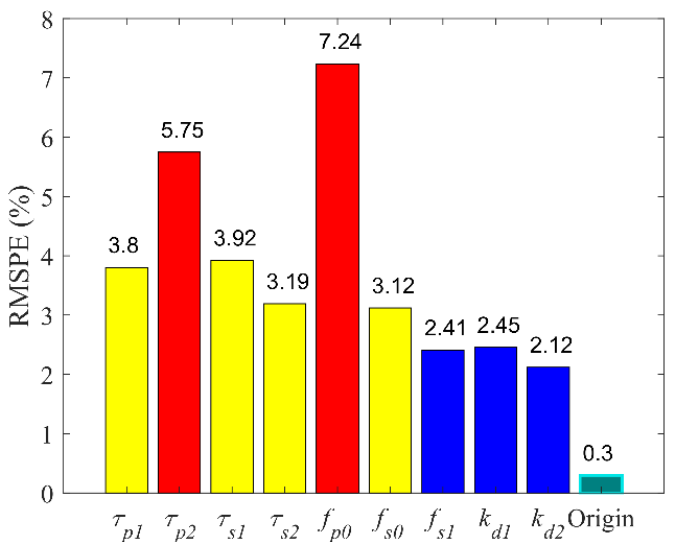
Figure 10. Sensitivity of nine parameters in pupillary light reflex inherent model.